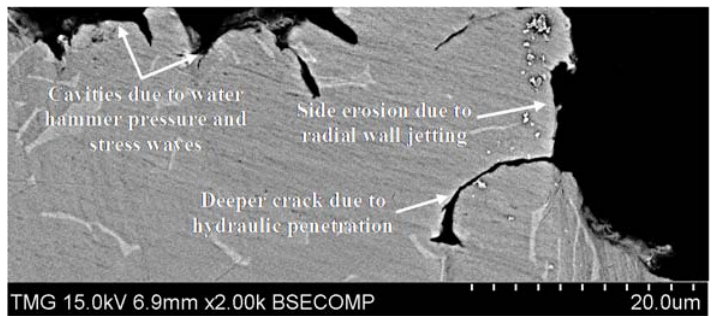
Figure 18. SEM micrograph shows the LIE damage of a DR-treated sample in stage 1 and 2 due to the combination of the water hammer pressure, stress waves, radial wall jetting and hydraulic penetration